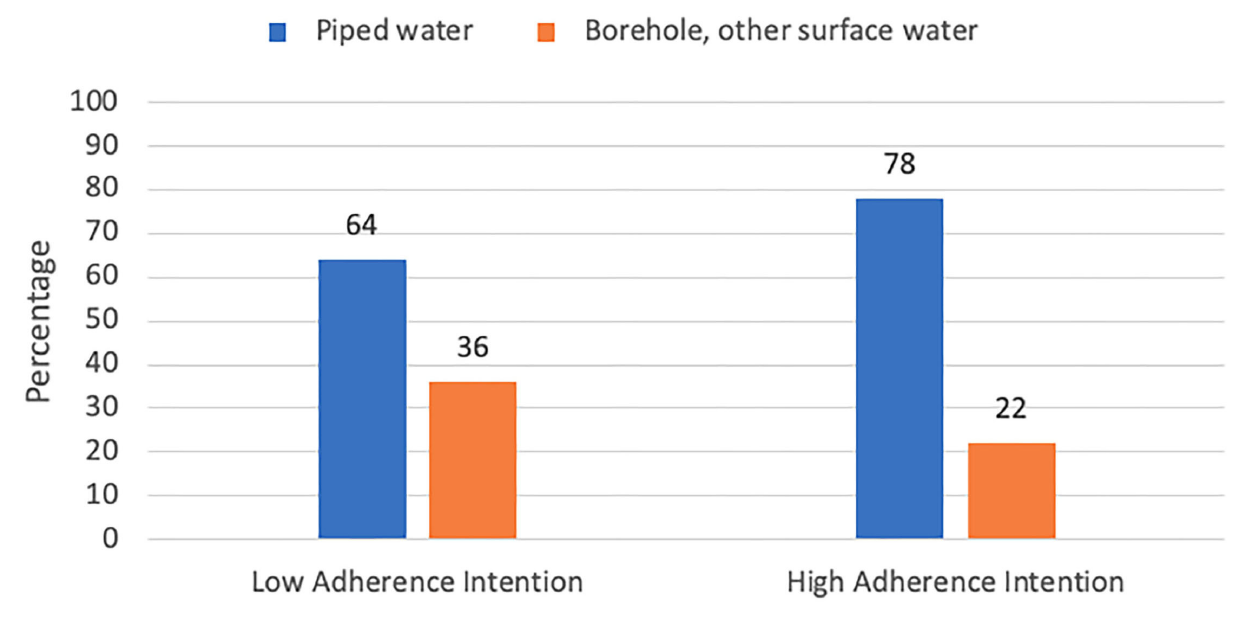
FIGURE 1 | Water access source by adherence intention